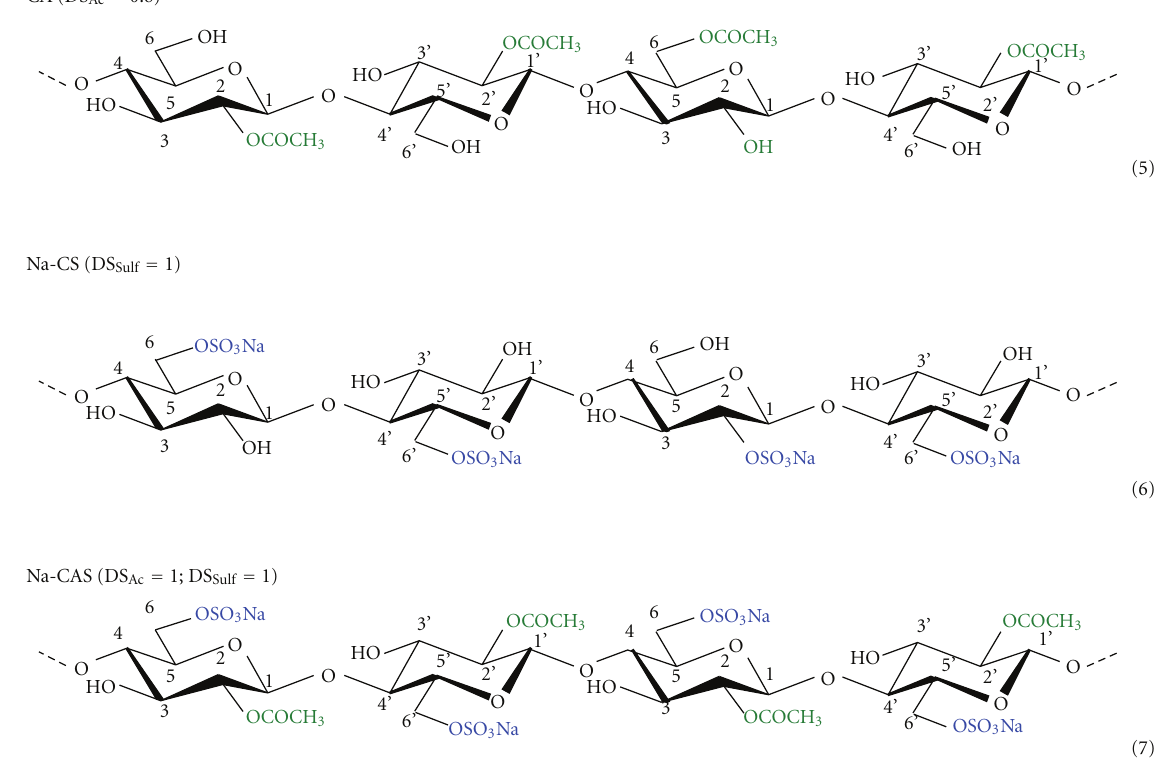
Figure 3: Representation of di ff erent cellulose derivatives polymer chains.